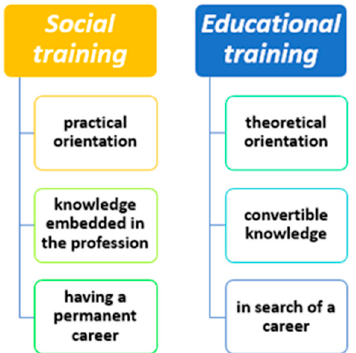
Figure 1. Typology based on the properties of the training programs.